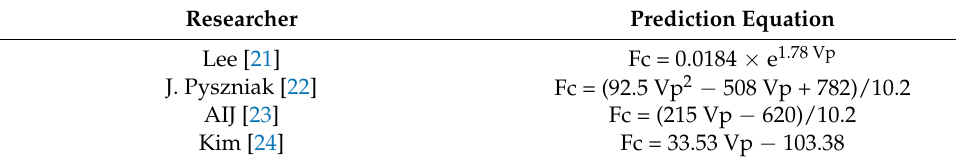
Table 1. Previous study for developing prediction equations.